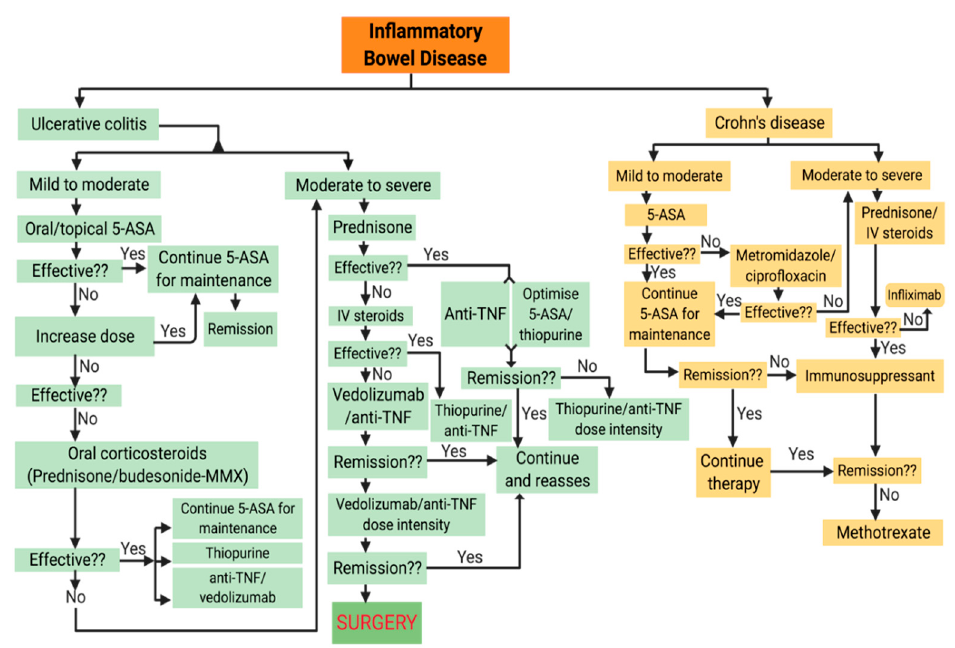
Figure 7. Current treatment options for Inflammatory Bowel Disease (both ulcerative colitis (UC) and Crohn’s disease (CD)).